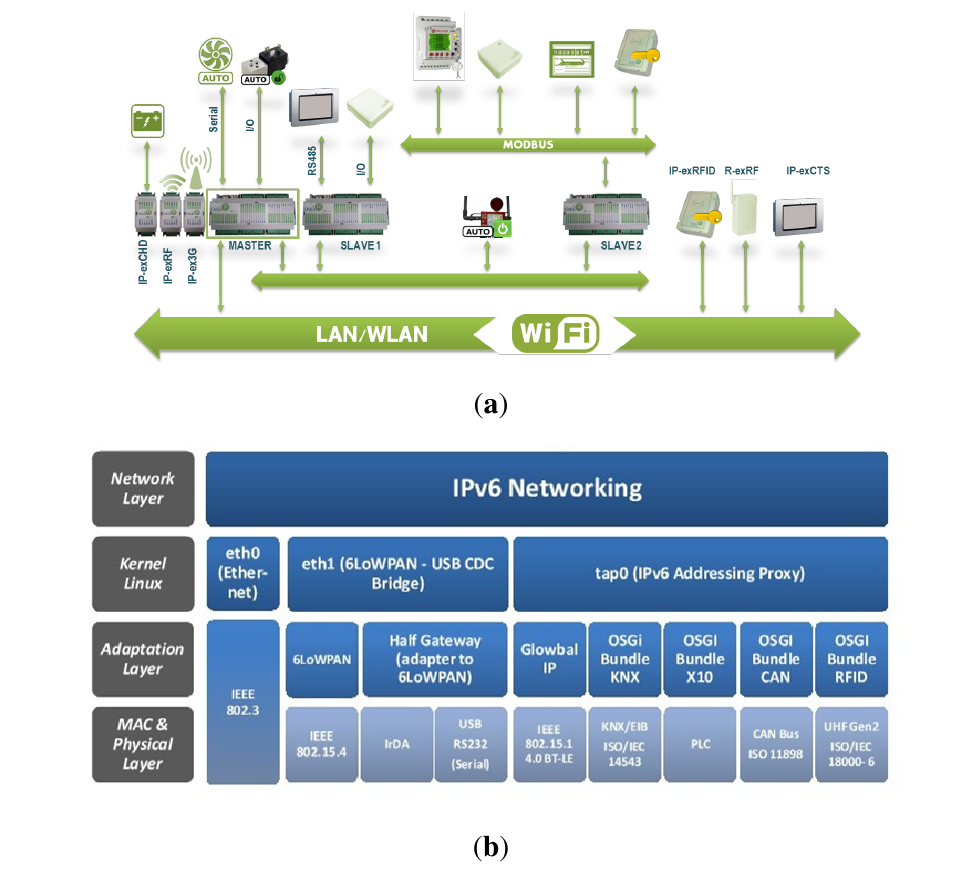
Figure 2. Schemas of integration in City explorer. ( a ) Schema of components integration in City explorer platform; ( b ) Schema of technologies integration in City explorer